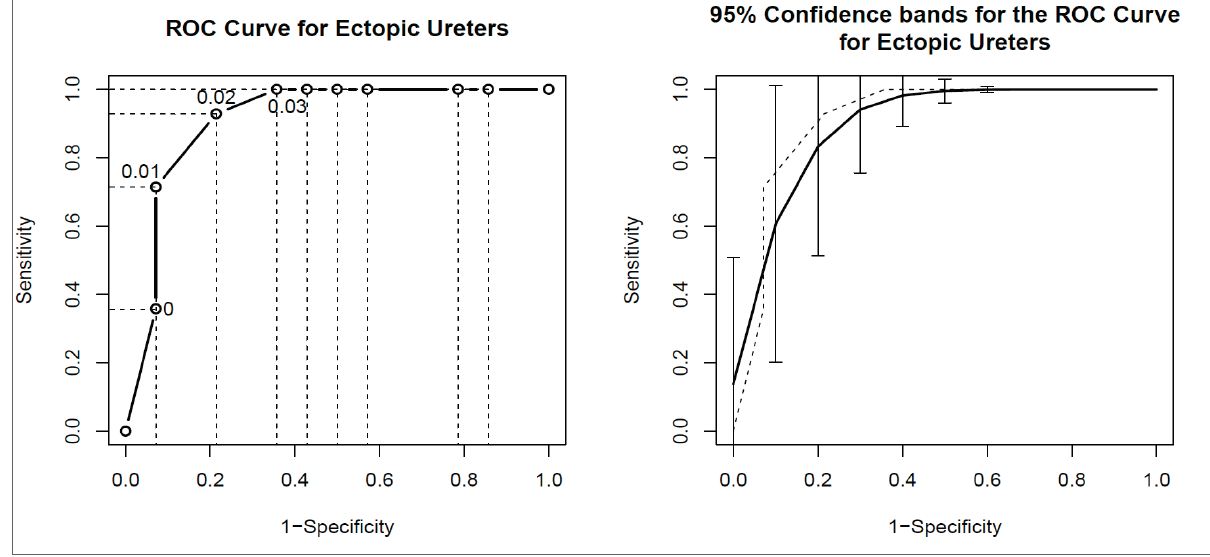
Fig. 4. roc curve illustrating the quality of predictions under various thresholds. The model predicts irreversible histological lesions in patients with the Up differential function equal to 2% or